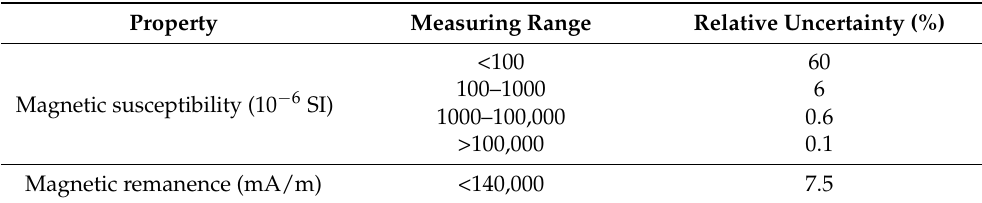
Table 1. Measurement uncertainties for different measuring ranges of magnetic susceptibility and